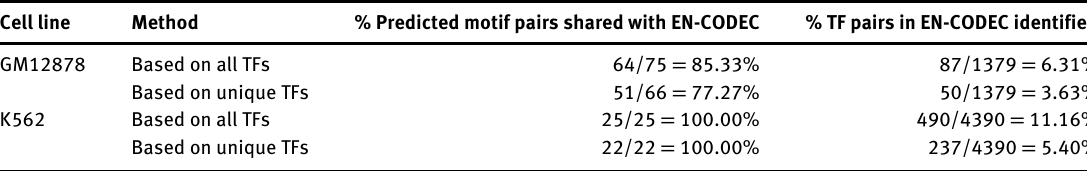
Table 2: EP motif pair comparison with